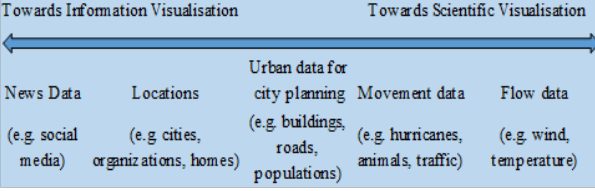
Figure 1. Real world examples of visualisation (Maceachren et al., 2005)